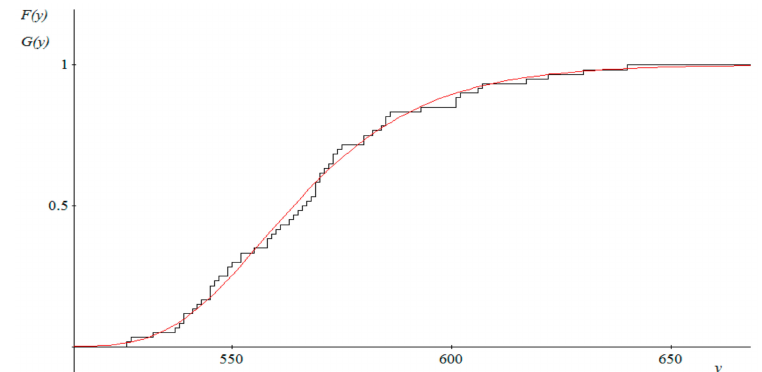
Figure 3. Graph of empirical distribution function (black) ˆ F ( y ) for random variable M 30 for period 2014–2018 in Widuchowa and graph of matched theoretical distribution function G γµ , σ ( y ) (red). Source: Own